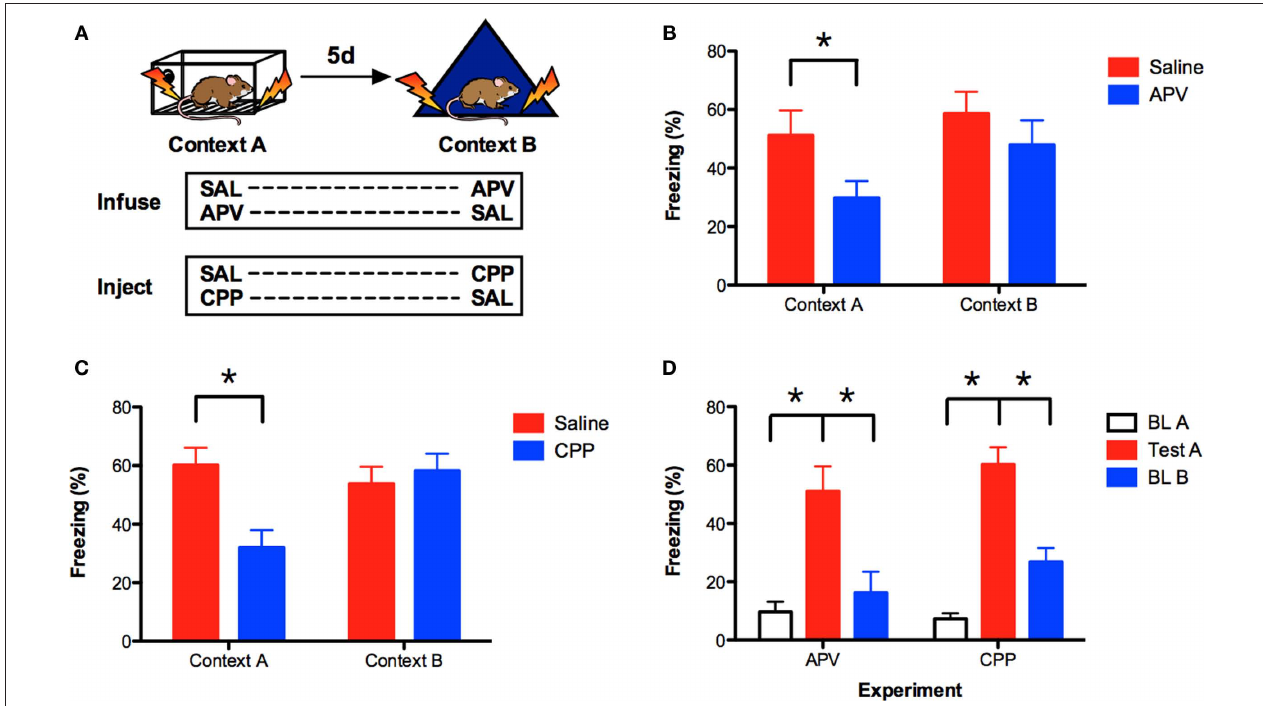
Figure 1 | Prior conditioning produces NMDAr-independent context fear learning in the hippocampus. (A) Mice were fear conditioned in context A, and then trained in context B 5 days later. Saline or APV was infused bilaterally into the dorsal hippocampus immediately prior to training in context A ( n = 7, n = 8) and context B ( n = 8, n = 7). In a separate experiment, saline or CPP was administered IP 30 min prior to training in context A ( n = 18, n = 21) and context B ( n =